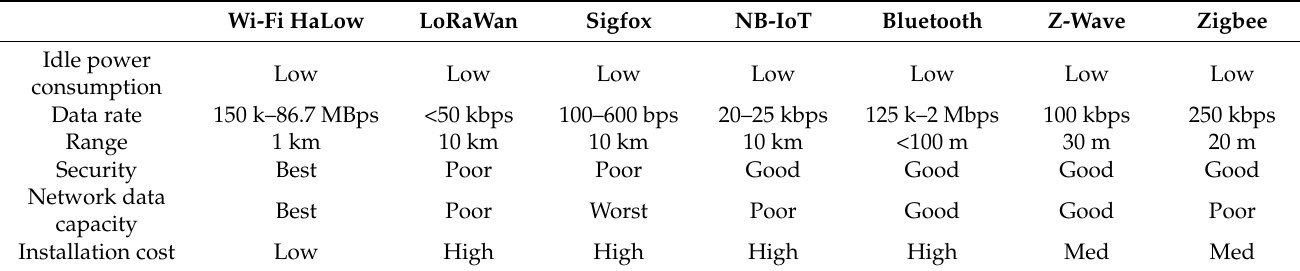
Table 1. Characteristics of different physical layer standards for